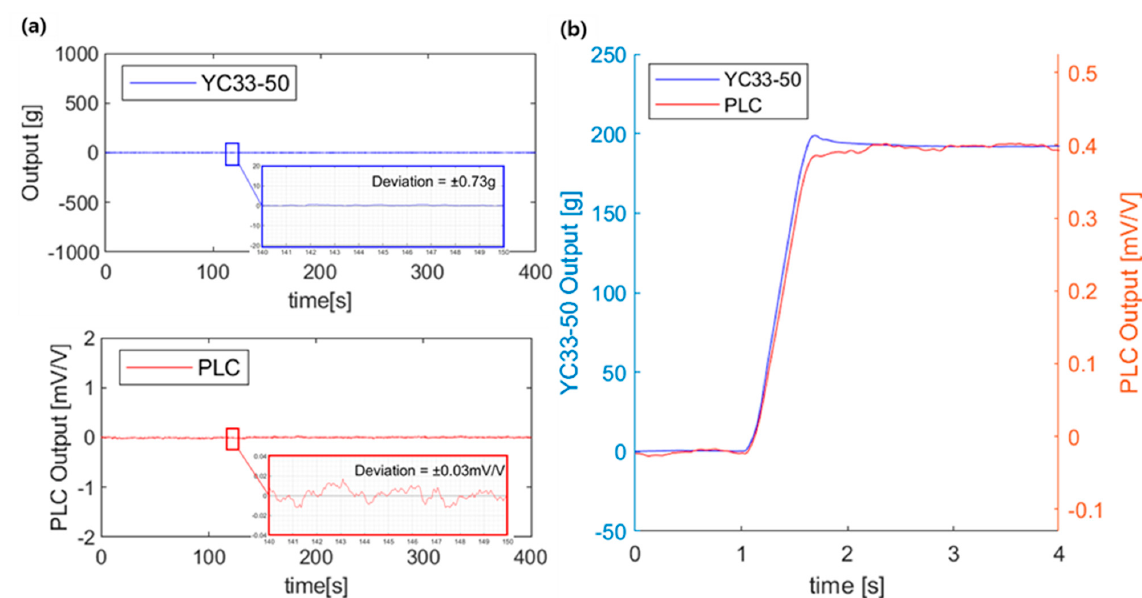
Figure 7. Response profiles of the 3D PLC and the commercial load cell: ( a ) voltage outputs under no loading; and ( b ) voltage outputs under a static load 0.2 kg (step response).